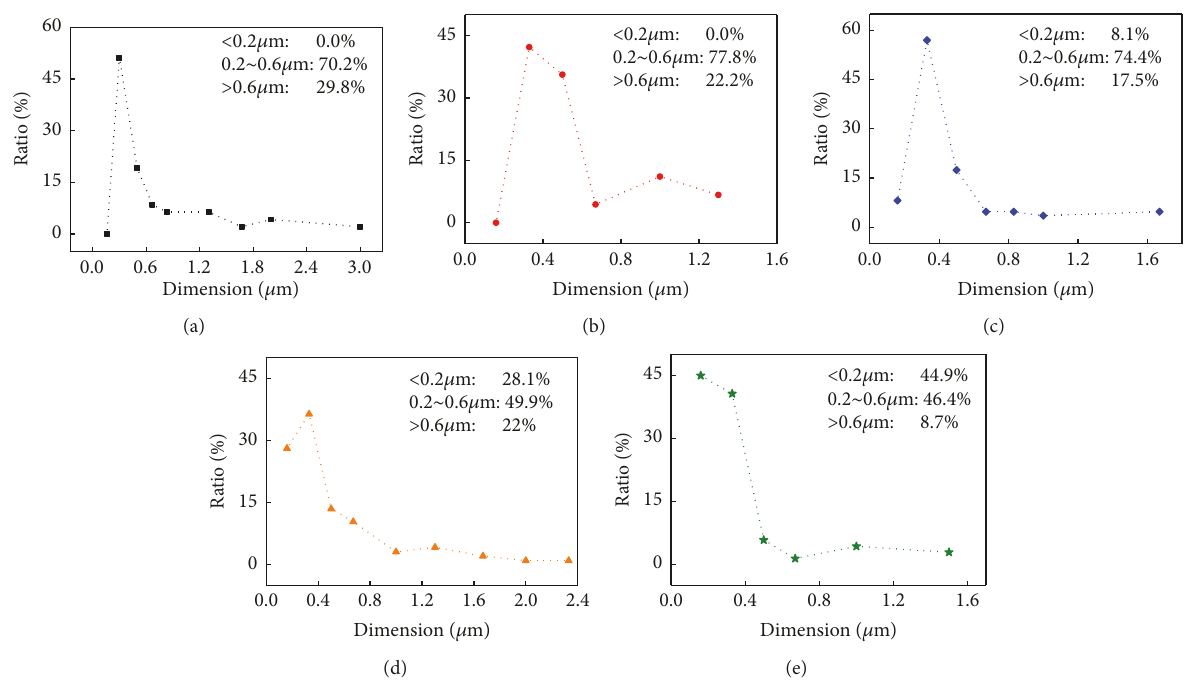
Figure 6: Dimension (size) and ratio of the second-phase particles in welded metals with different REE contents: (a) REE-free, (b) 0.3 wt.%, (c) 0.5 wt.%, (d) 0.7 wt.%, and (e) 1.0